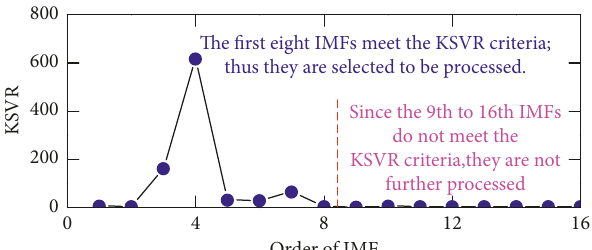
Figure 19: Kurtosis of the SVR spectra of the IMFs obtained by CEEMDAN for a compound fault